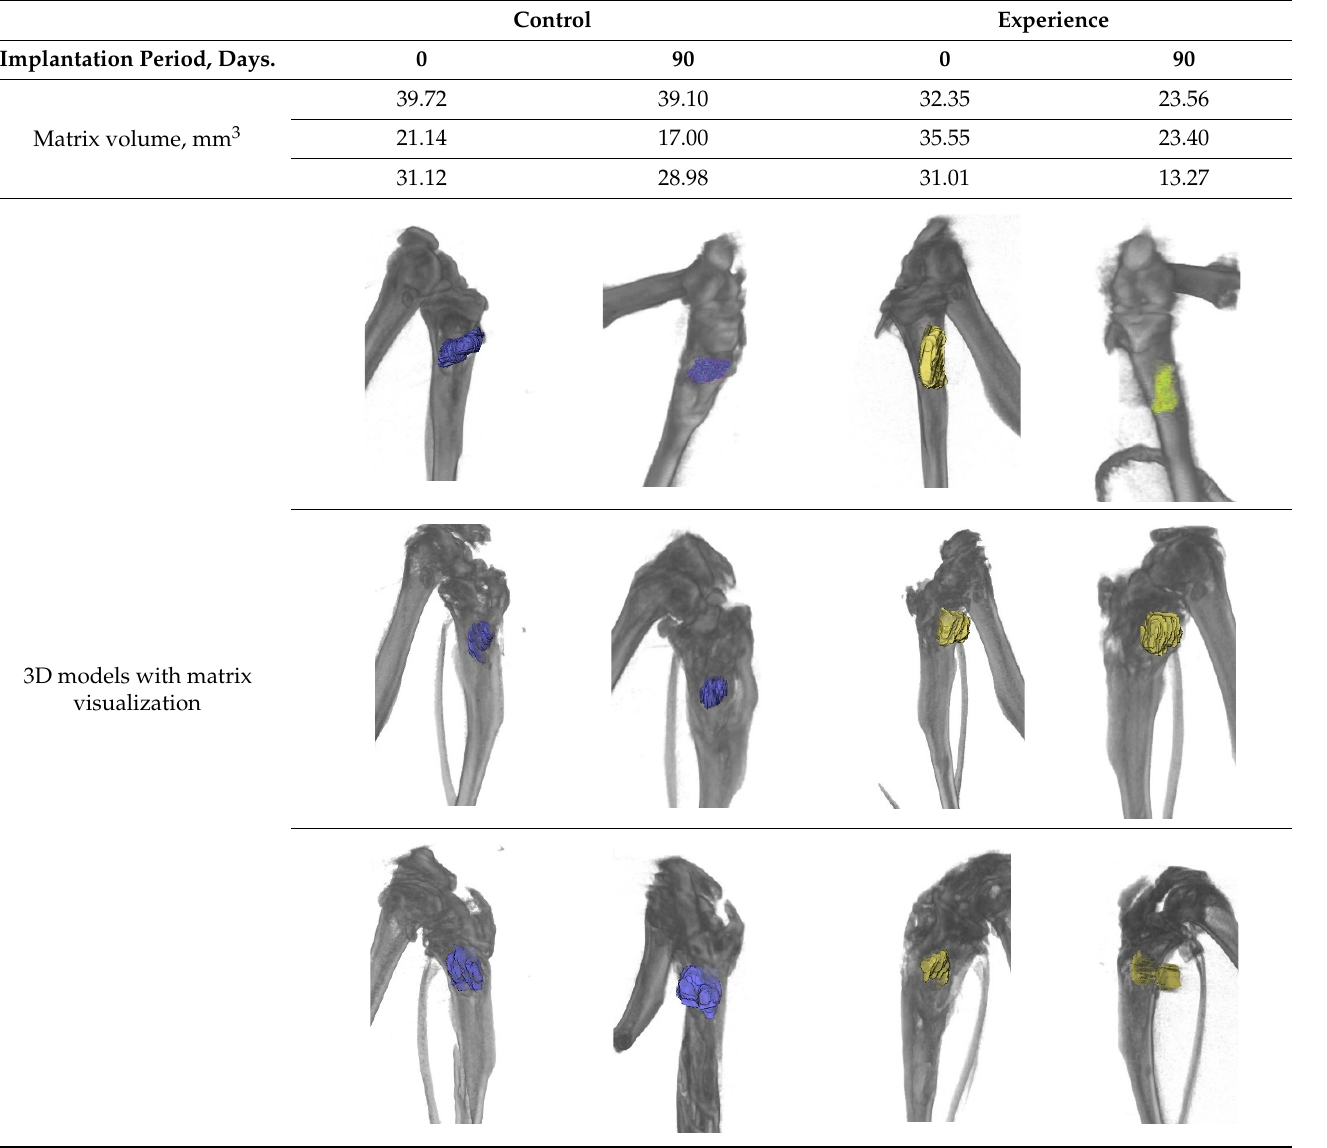
Table 4. The volume of the implant and the 3D model of the tibia of a laboratory animal, created from CT results.